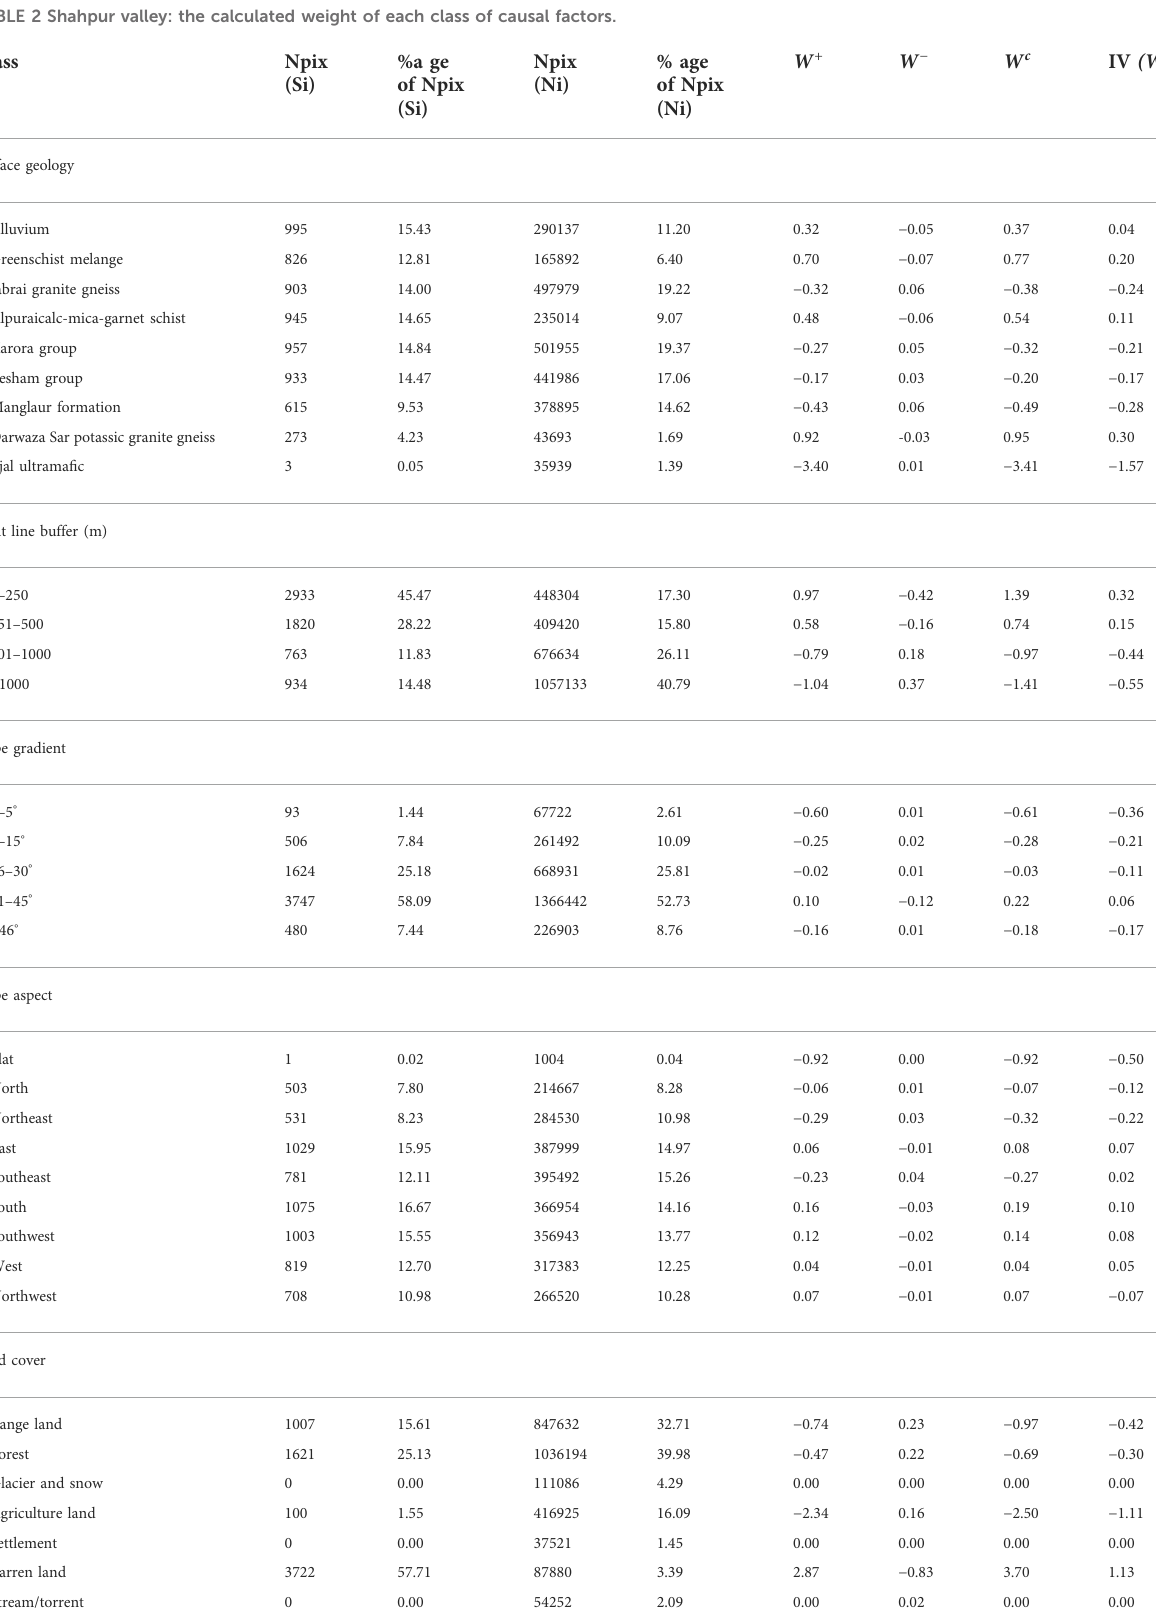
TABLE 2 Shahpur valley: the calculated weight of each class of causal